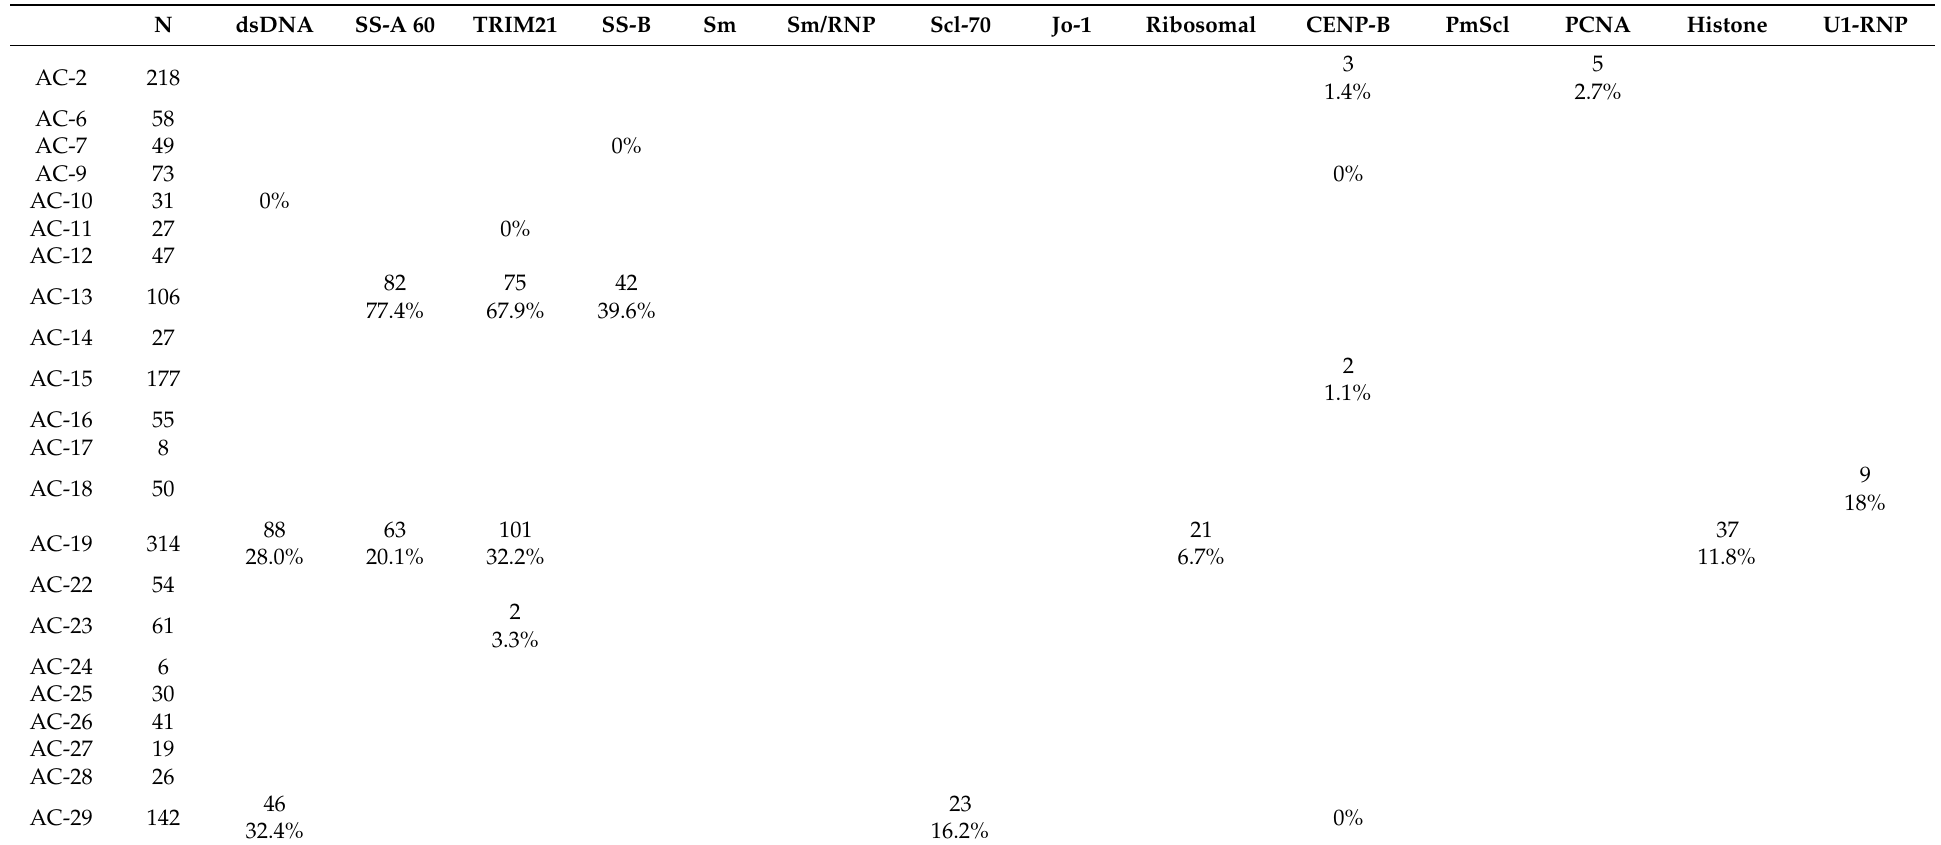
Table 2. Differences in distribution of specific antibodies in samples with particular rare IIF